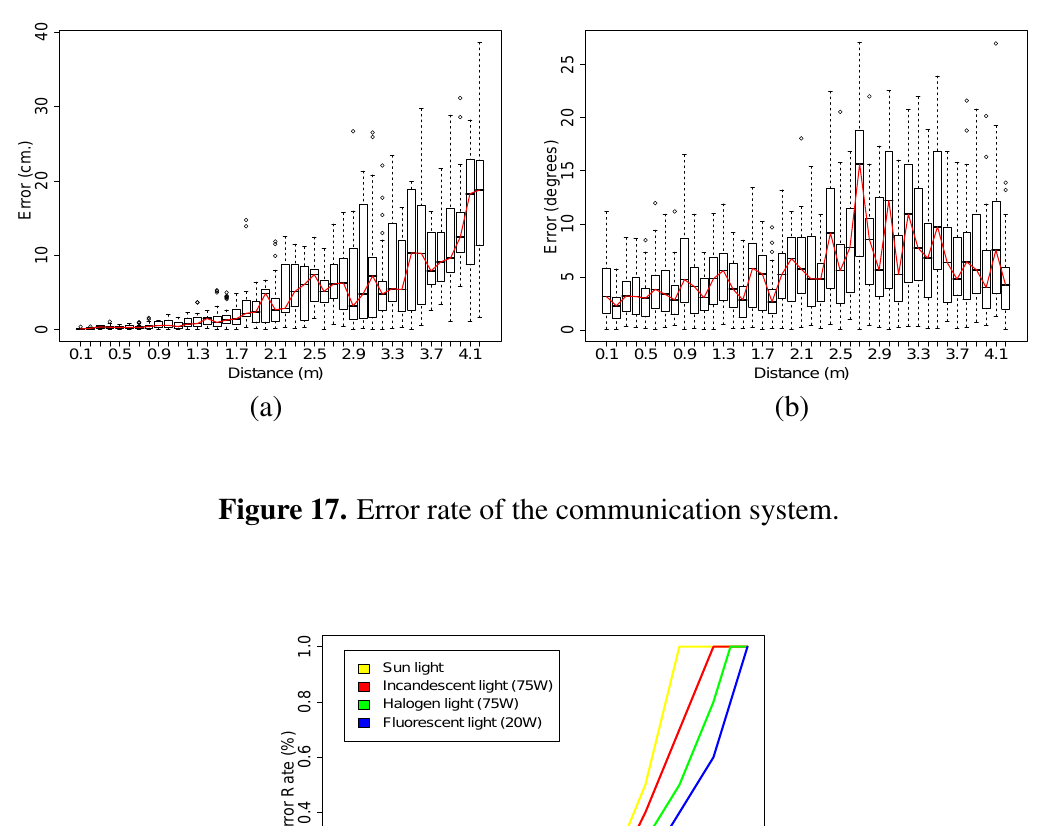
Figure 16. (a) Standard deviation of the distance estimated with respect to the actual distance between emitter and receiver. (b) Standard deviation of the angle estimated with respect to the actual relative orientation between emitter and receiver.